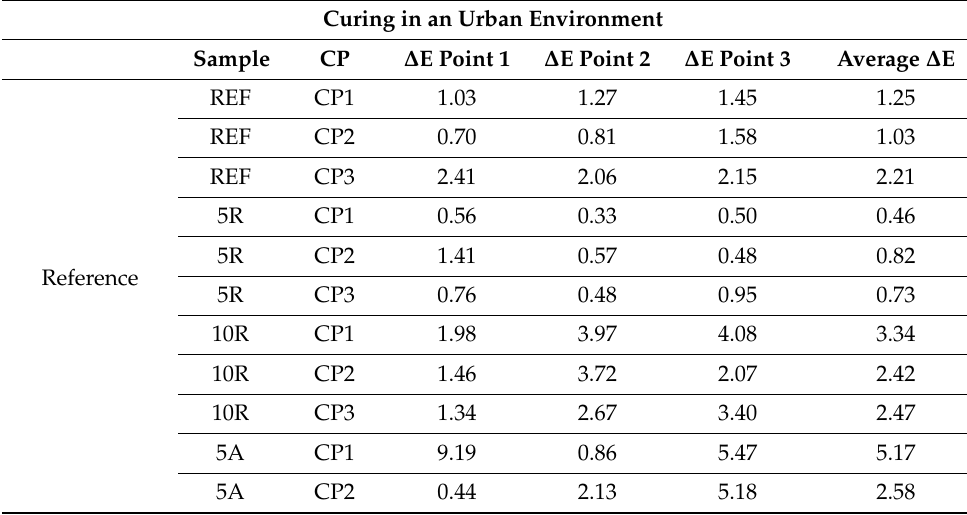
Table A2. Color variation of cement tiles after exposure to an urban